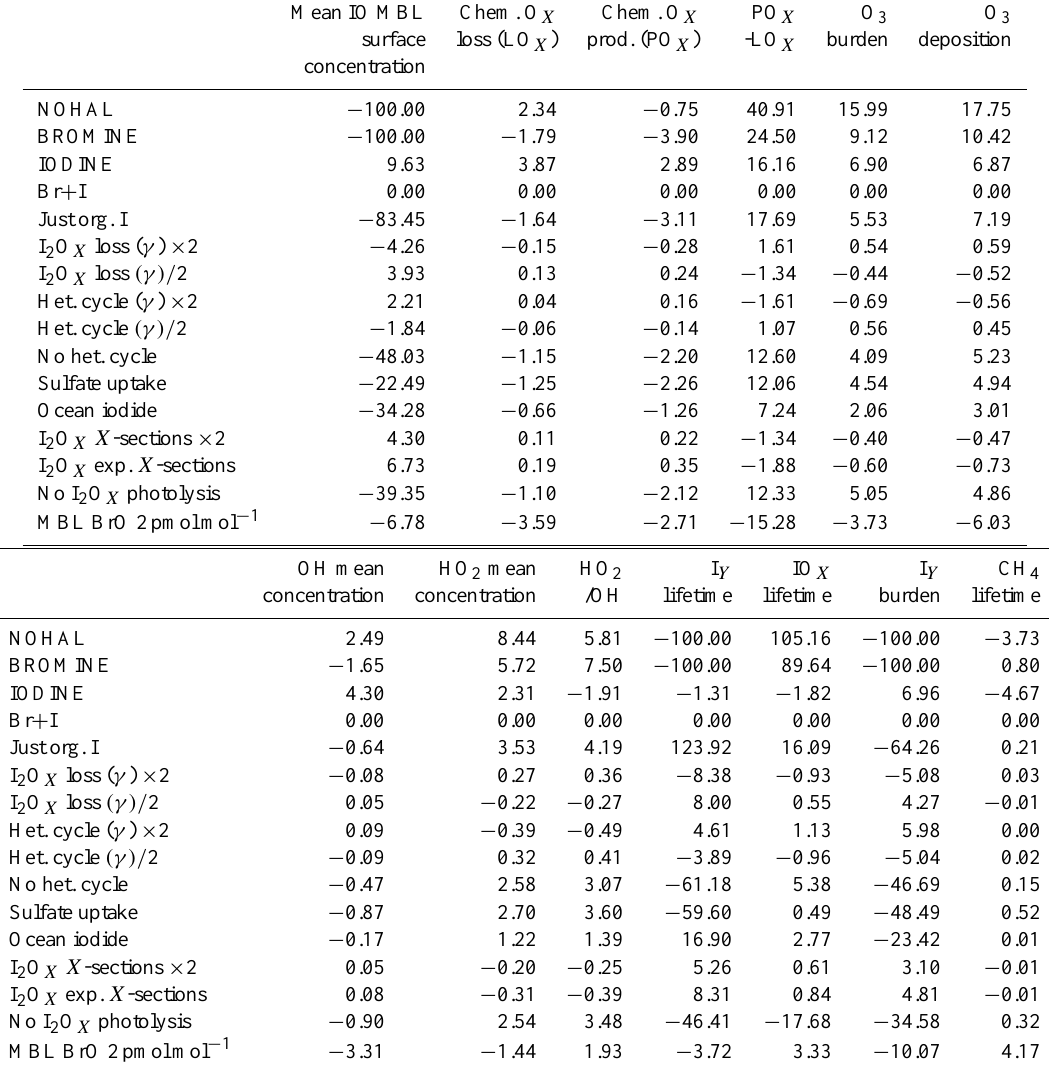
Table A1. Effects of sensitivity runs on relevant variables. Values are shown as percentage change from the simulation with both iodine and bromine chemistry (“Br + I”) in the troposphere as global means unless otherwise stated. MBL = Marine Boundary Layer (900hPa <p ), O X is defined as in footnote 1. CH 4 lifetime is calculated globally in the troposphere with respect to loss by reaction with